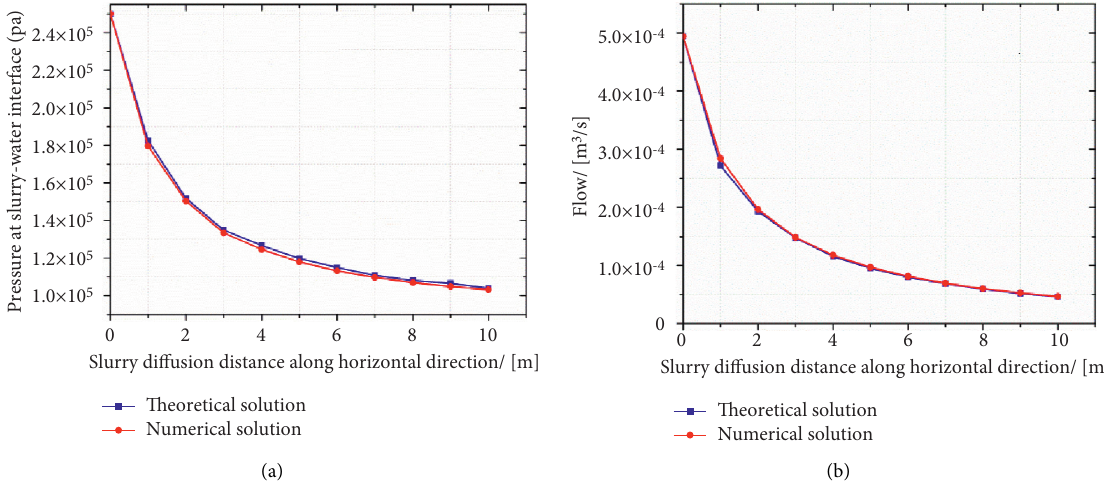
Figure 8: Comparison of numerical results and theoretical results. (a) Pressure of the slurry-water interface. (b) The value of system slurry